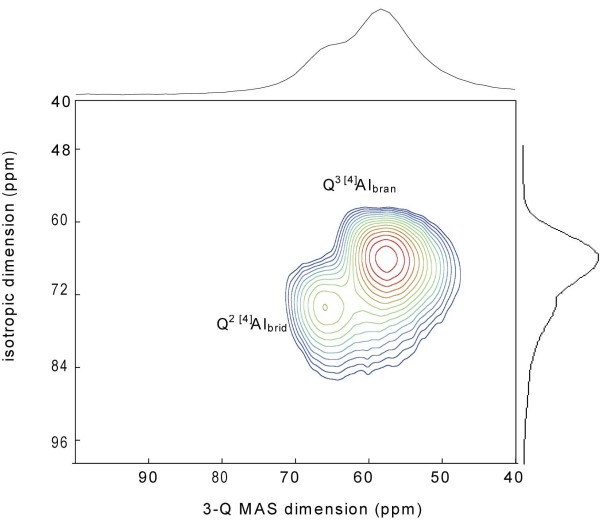
27Al 3Q-MAS NMR of tobermorite (t = 24 h sample). These data show two structurally distinct [4]Al sites from Q2 bridging (Q2 [4]Albrid) and Q3 branching (3Q [4]Albran) chains within the tobermorite framework.